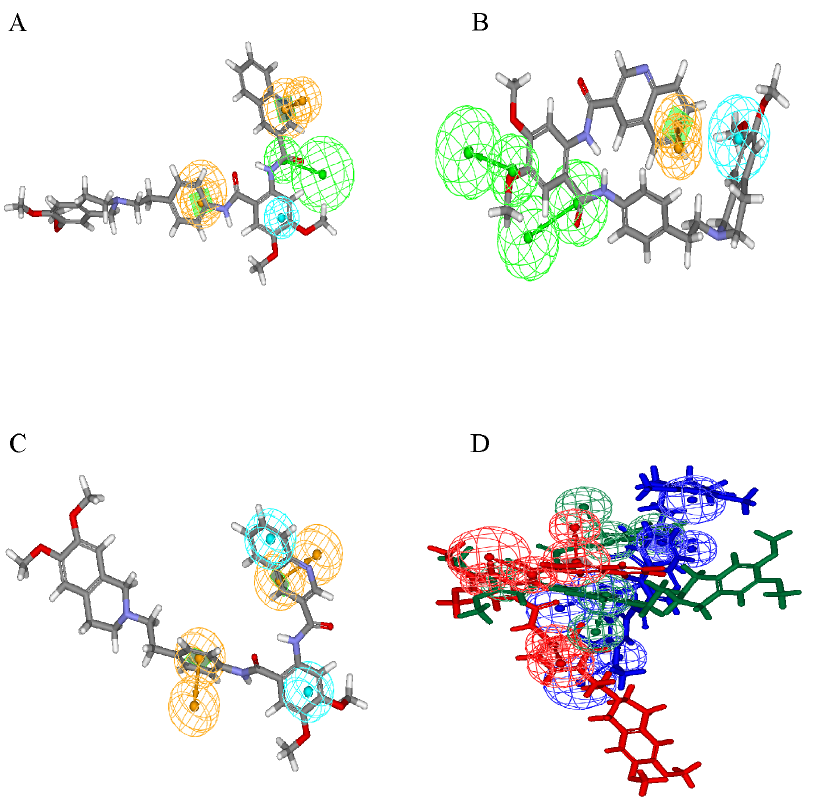
Figure 4. Superposition of pharmacophore models and 22. Pharmacophore models (A) Hypo A, (B) Hypo B, and (C) Hypo C fitted to 22 and (D) overlay of these three models, which are color-coded by red, blue, and green, respectively. The chemical features are described in Figure 1.